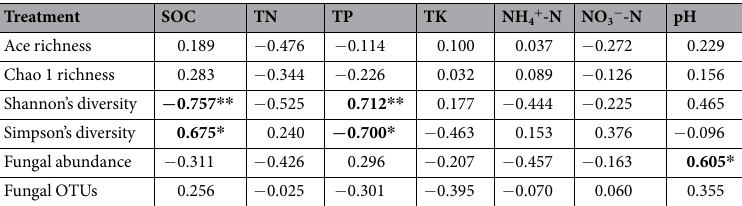
Table 3. The Spearman’s correlations among the fungal community and soil